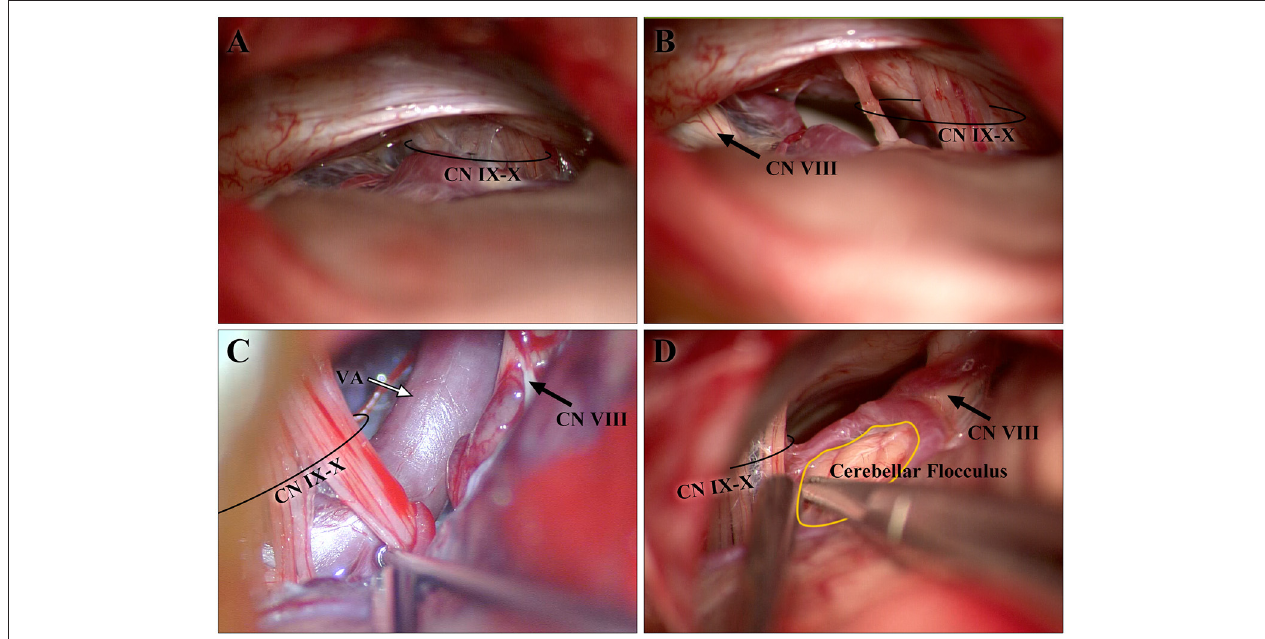
FIGURE 5 | Images from intraoperative microscopy. (A,B) are both from one patient. The CN IX-X shown in (A) emerged after retraction of the cerebellum during the early stage of the operation, whereas CN VII-VIII had not yet become visible. The CN VII-VIII in (B) appeared after sharp separation and adjustment of the optical axis of the microscope. (B) The cisternal segments of CN IX-X and CN VII-VIII are shown. As CN IX-X and CN VII-VIII arise from the brainstem and gradually separate, the distance is longer than that in the study. (C,D) show the developed cerebellar flocculus and vessels around the CN IX-X REZ, respectively. CN, cranial nerve; REZ, root entry/exit